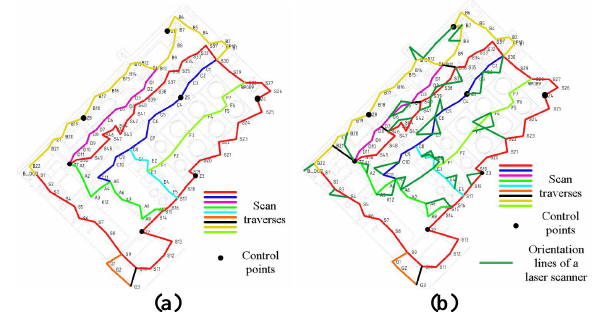
Figure 1 . The scheme of creating horizontal and vertical control survey network and scan traversing for the territory of the central gathering oil station: